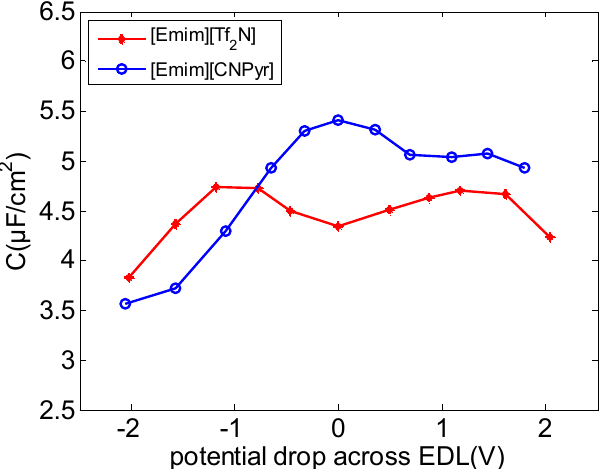
Figure 7. The differential capacitance versus the potential drop (V) across the EDLs of [Emim][Tf 2 N] and [Emim][CNPyr], respectively, at 350 K.